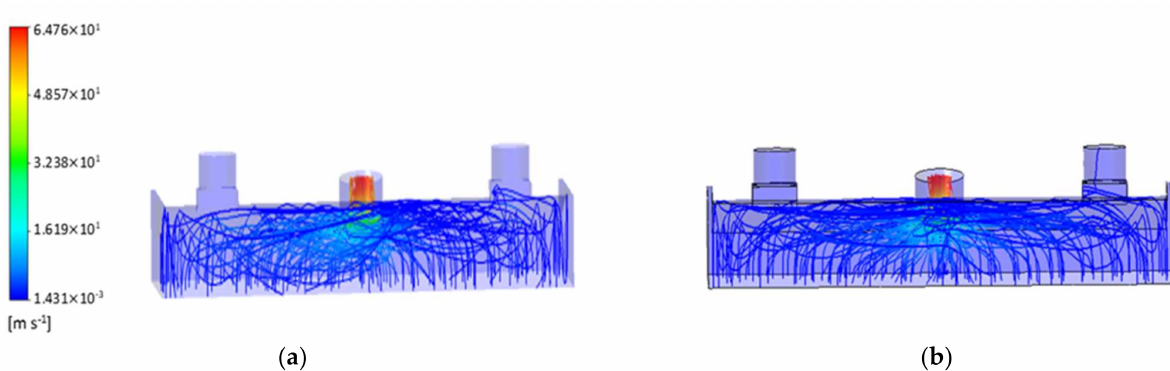
Figure 8. The results of simulating the effect of changes in particle composition on the road surface on particle velocity and trajectory. ( a ) Wood-volatiles dust; ( b ) Aluminum-solid